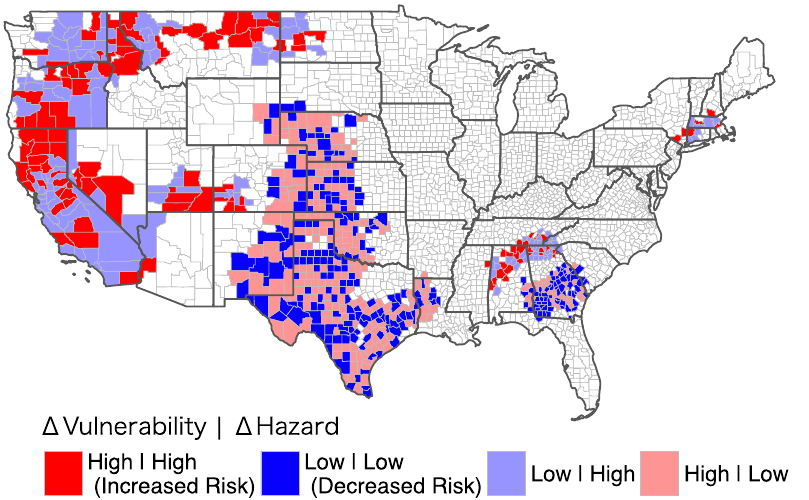
Figure 6. Changes in total risk of drought from the first to the second study period. The maps show the results of bivariate differential Local Moran’s I analysis with change in total vulnerability as the main and change in total hazard as spatial lag variables. High (Low) indicates higher (lower) than the total average of the corresponding variable in all counties.